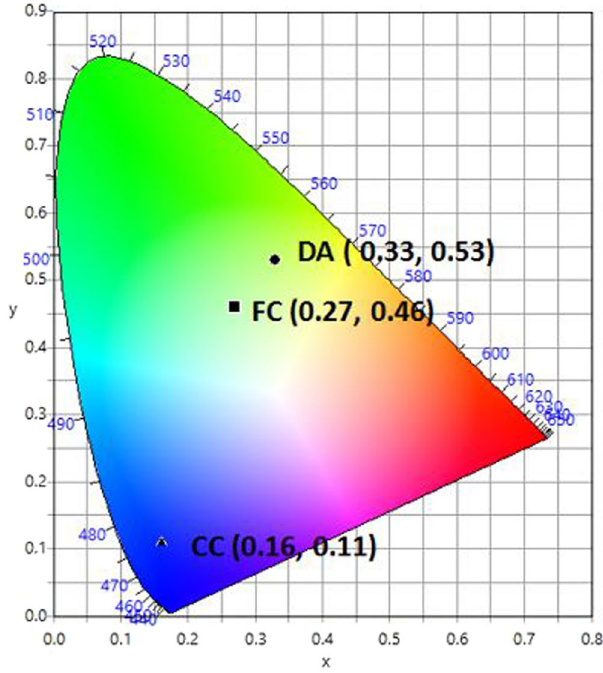
Figure 3. CIE-1931 diagram. Chromaticity plot for colour coordinates of CC ( ▲ ), FC ( ■ ) and DA ( ●